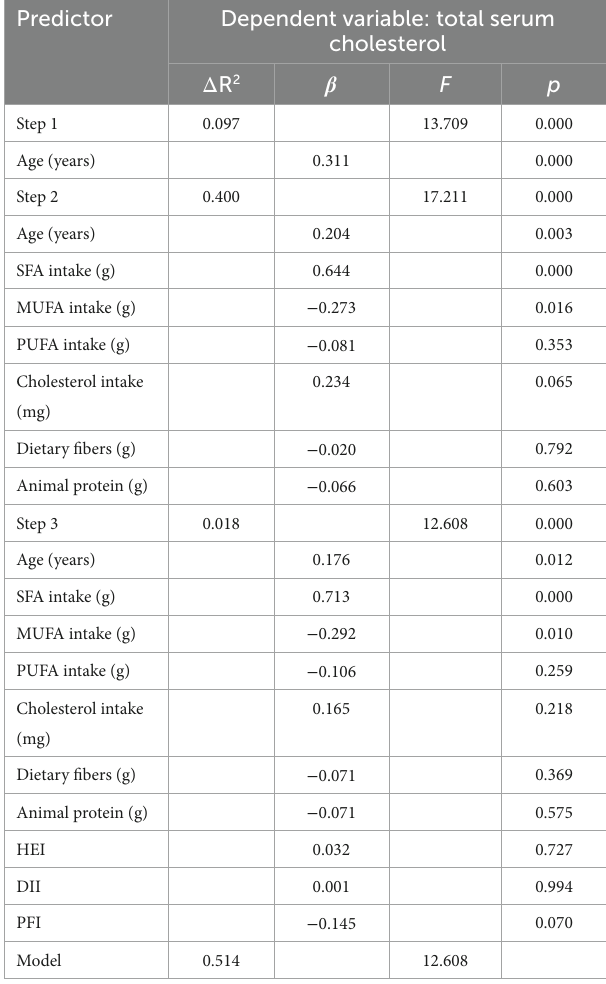
TABLE 6 Hierarchical regression model for total serum cholesterol. Predictor